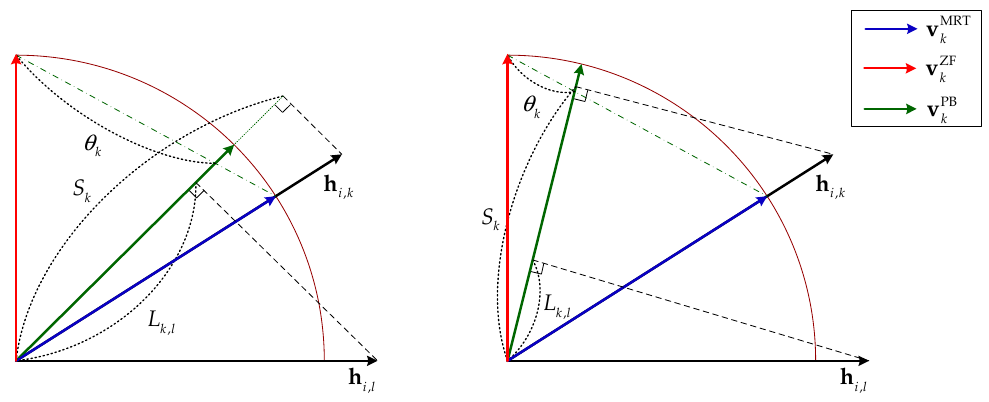
θ k . Figure 1. Behavior of parameterized beamforming (PB) according to parameter k